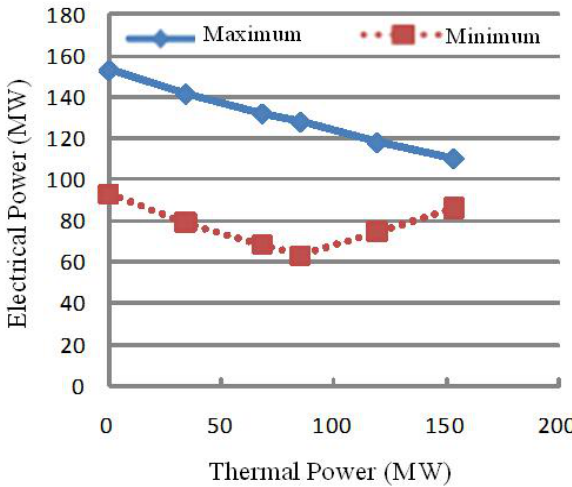
Figure 1. PQ-chart of